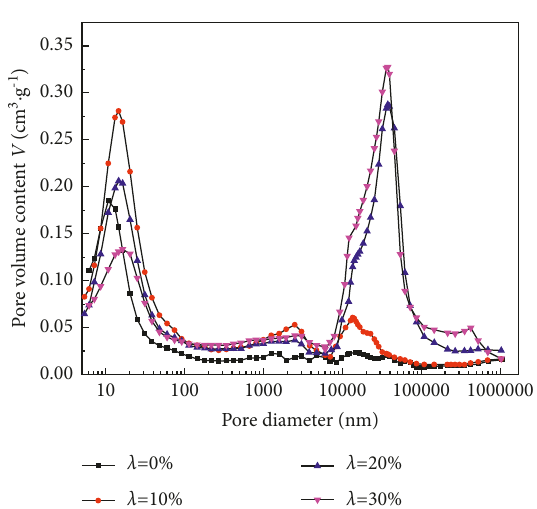
Figure 6: Pore accumulation curve of cement-soil samples with different HA content λ